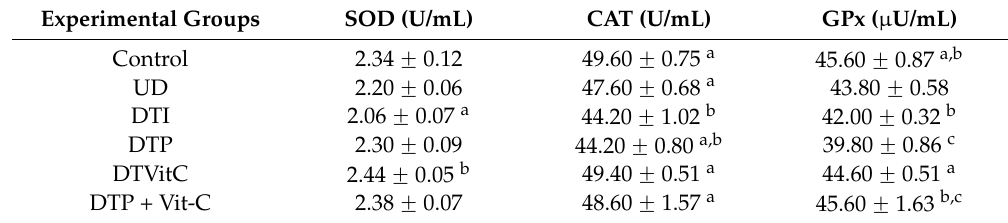
Table 2. Effects of treatment with insulin, probiotic and vitamin C on activities of serum antioxidant enzymes of alloxan ‐ induced diabetic rats.